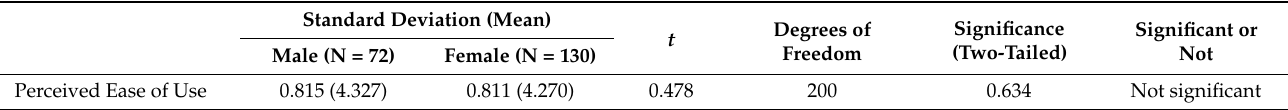
Table 9. T -test of the external variable of perceived ease of